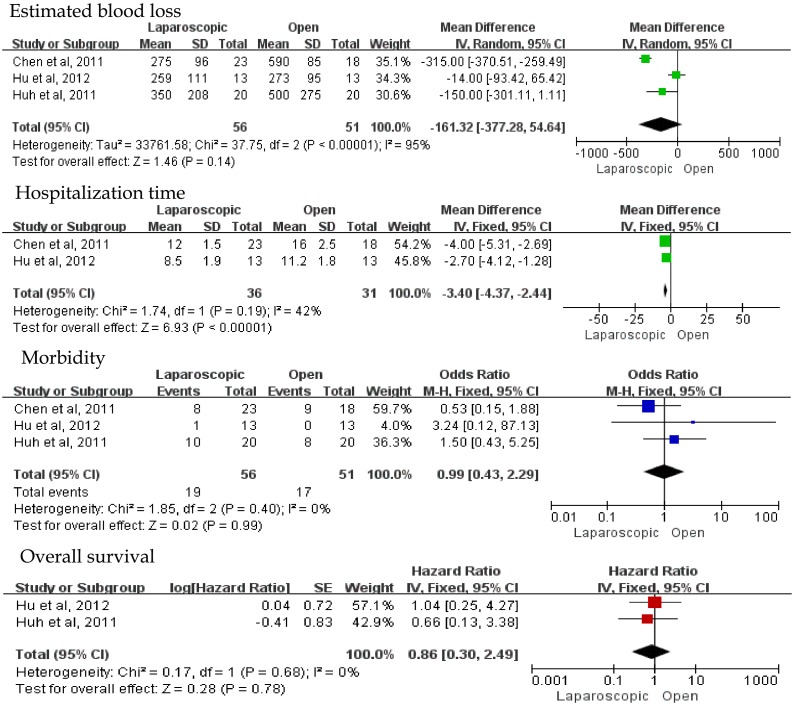
Forest plot of merged results in type of hepatectomy and synchronous colectomy.